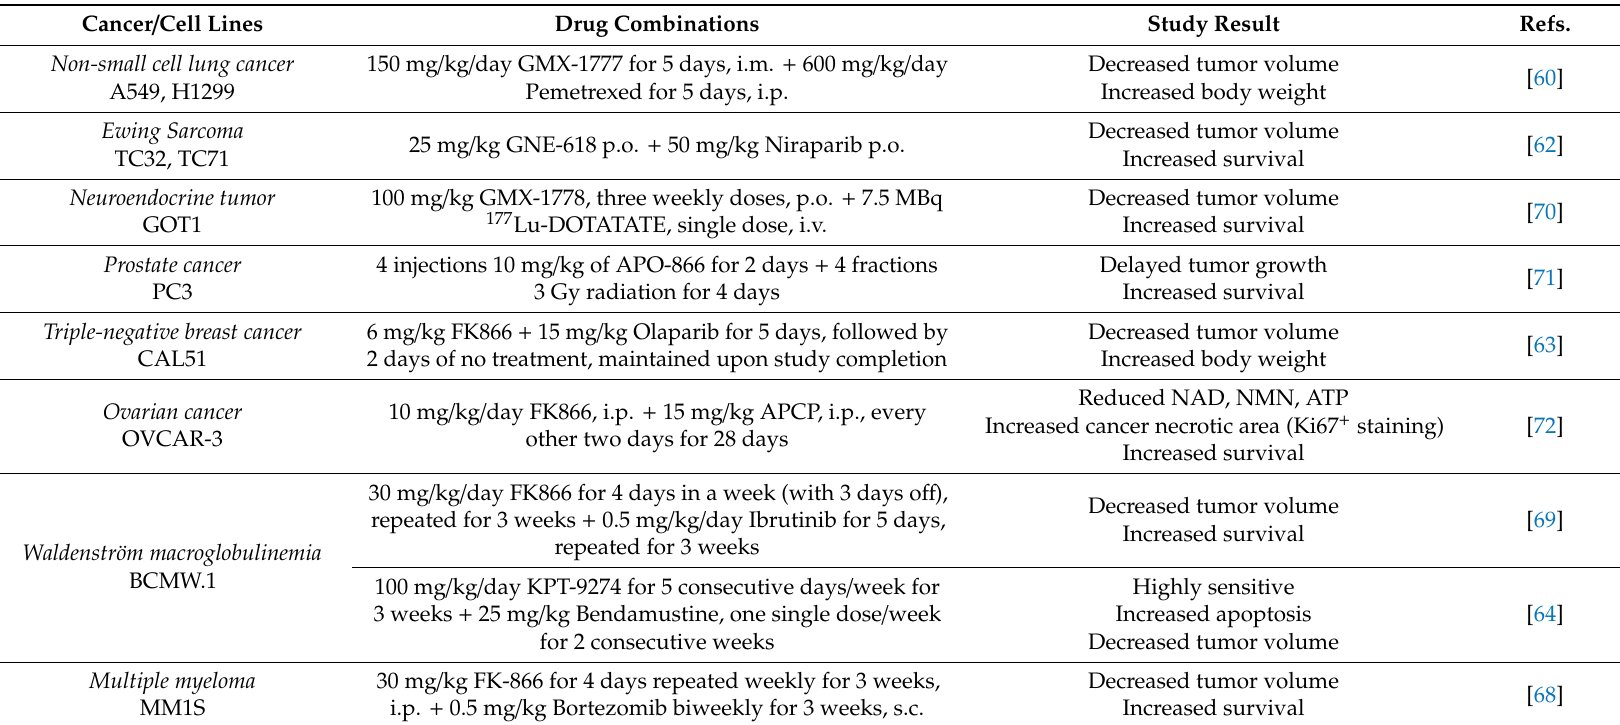
Table 3. Performance of NAMPT inhibitor in combination in